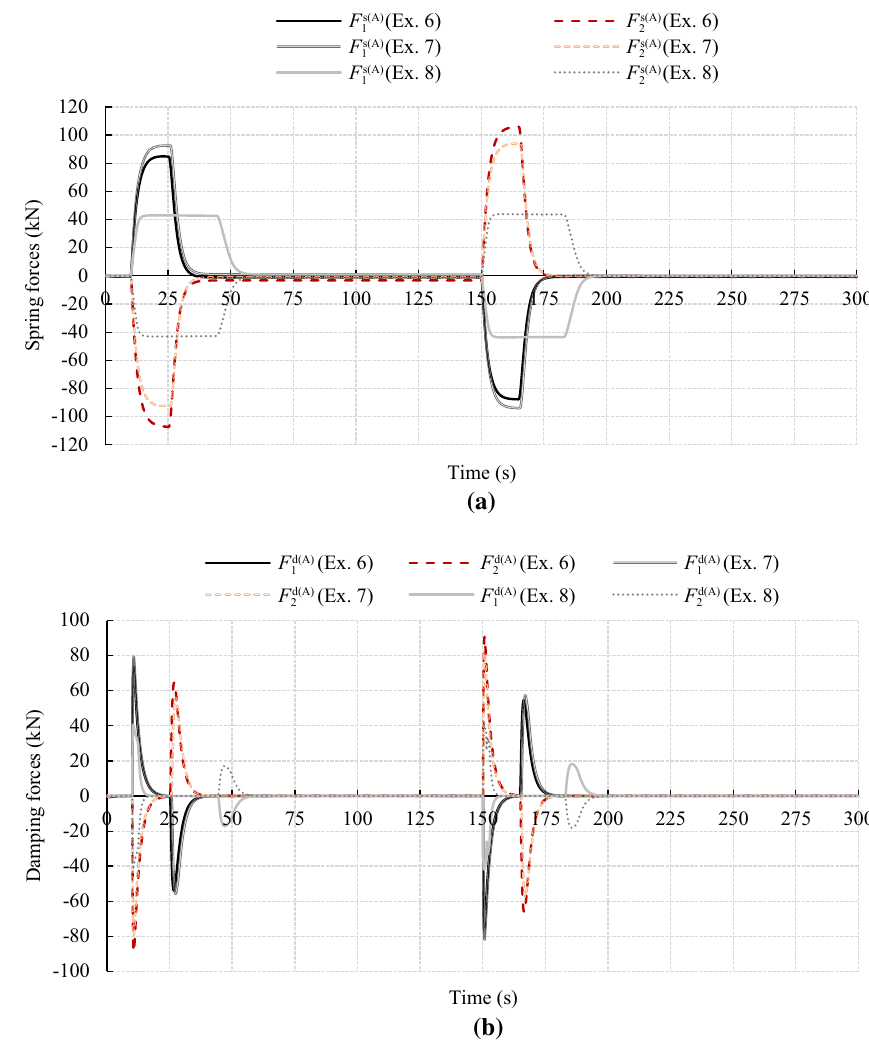
Fig. 13 Simulation results based on the LTD for model A of the push–pull MUT: a coupler spring forces F s A ð Þ damping forces F d A ð Þ and F d A ð Þ vs. time (in Ex. 6, passive vibration damping is only 1 2